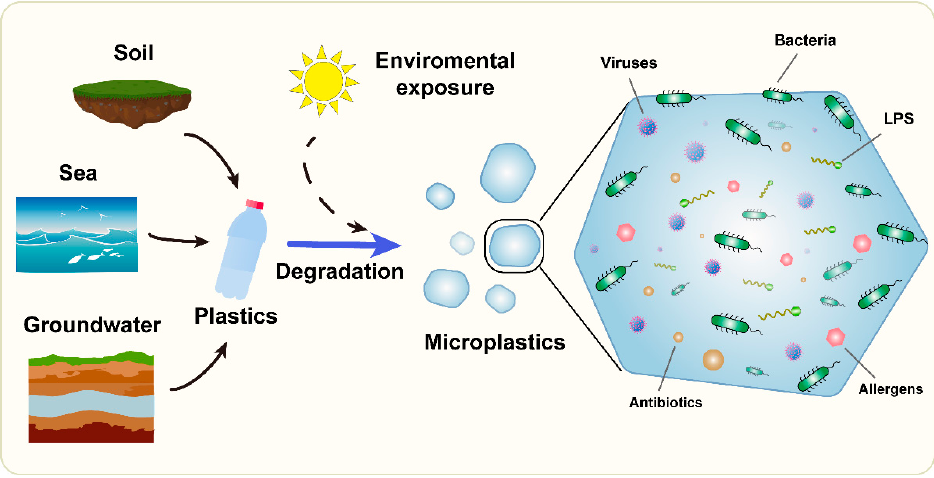
Figure 1. Microplastics as carriers of microorganisms and related molecules.